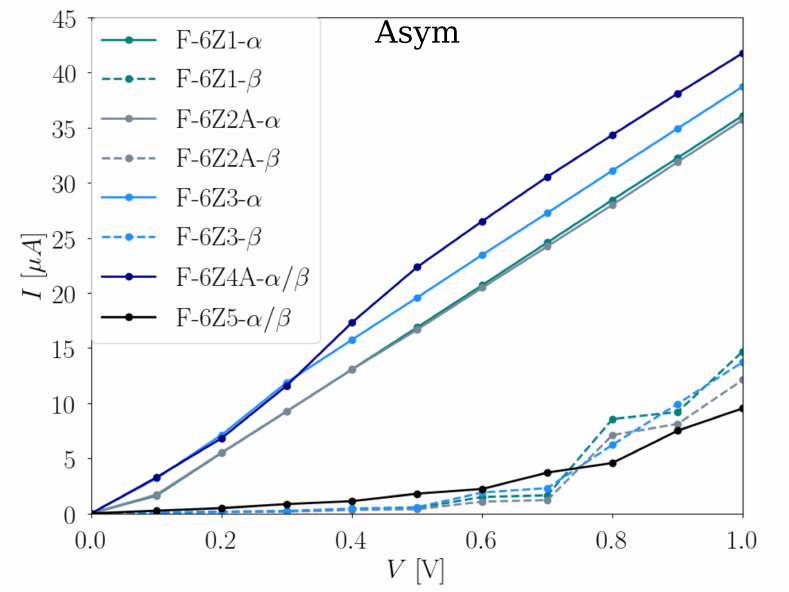
Figure 6. Total current I (µA) in dependence of the applied bias voltage V (V) with a 0.1 V step for the asymmetric fluorinated F-6Zs structures with five different fluorination degrees illustrated in Figure 1. It is noted that the values evaluated at each 0.1 V step are linearly connected for a better visualization of the evolution in the I with the increasing